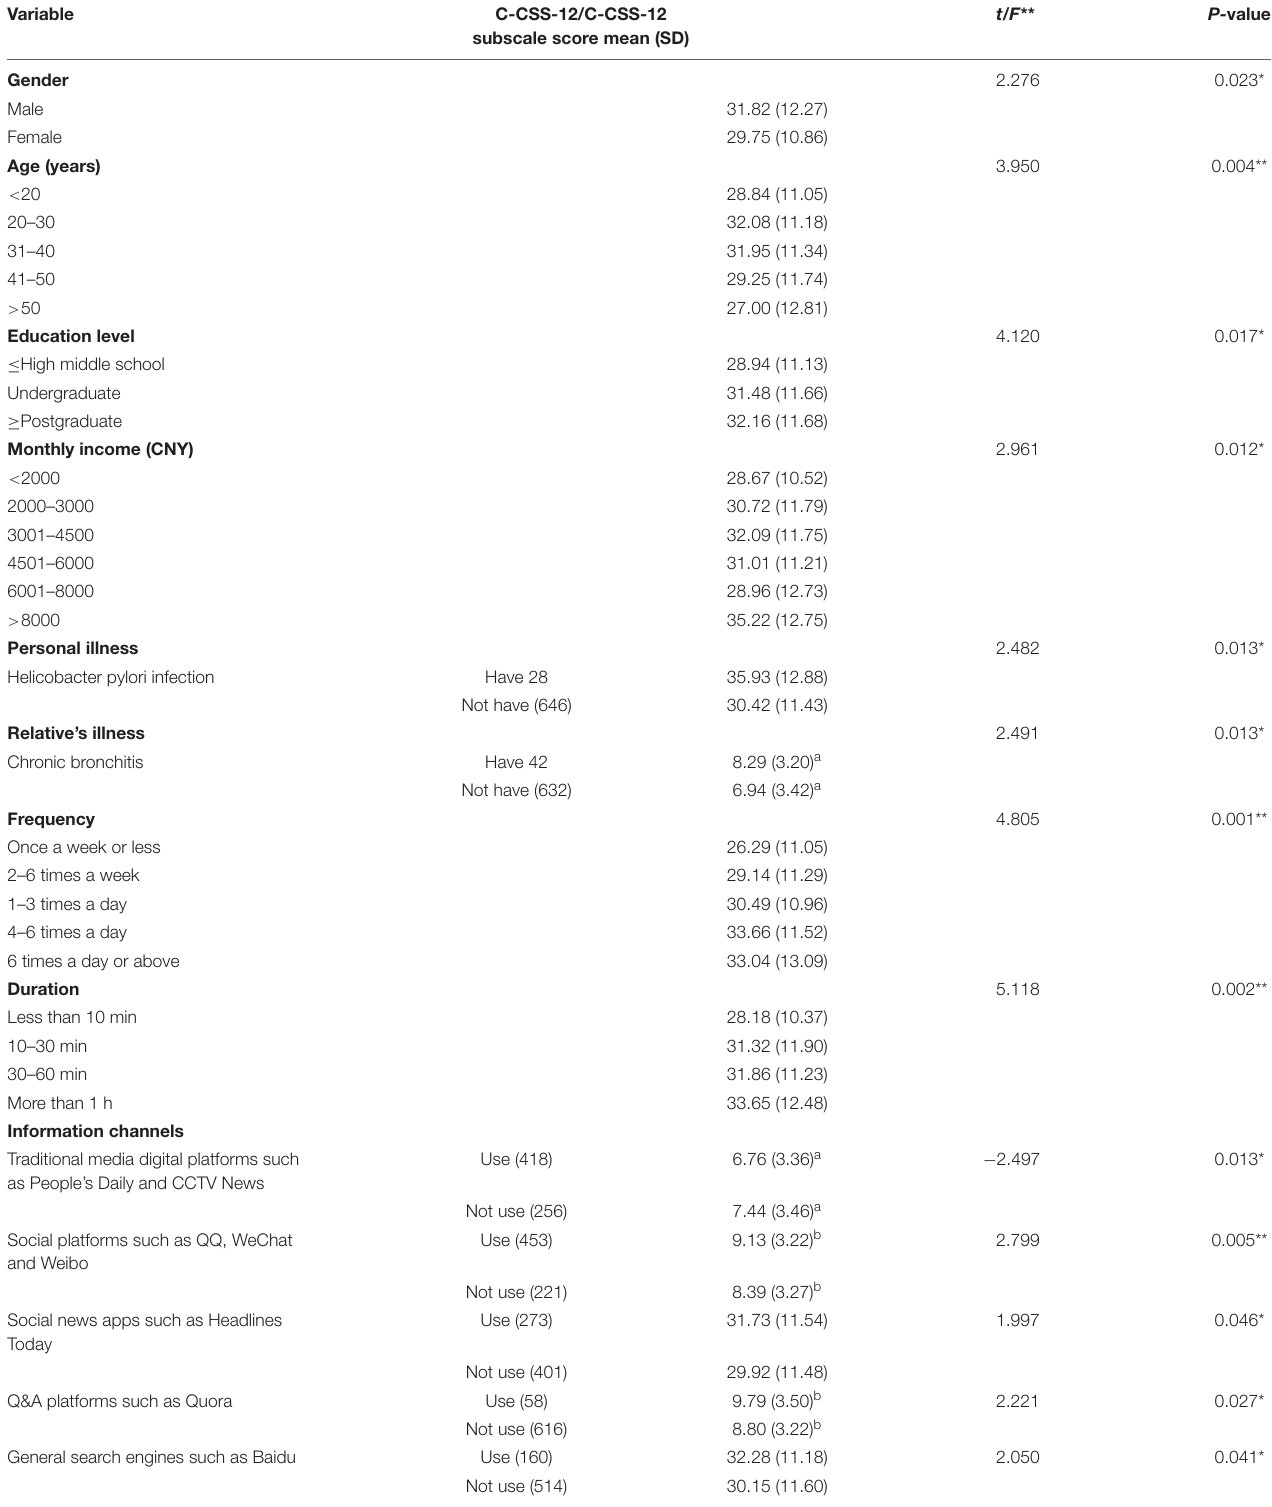
TABLE 4 | Cyberchondria (C-CSS-12) according to sociodemographic factors and COVID-19-related online information seeking behavior.